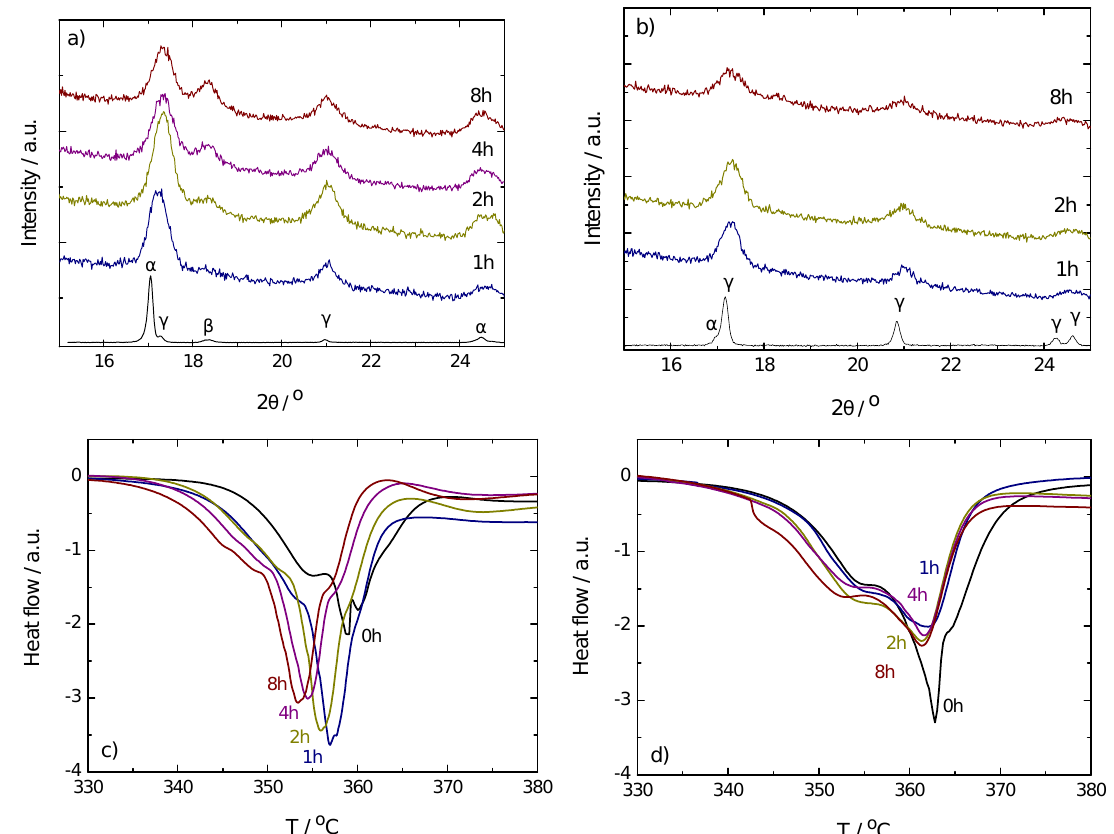
Figure 1. Top: Powder X-ray diffraction (PXD) results on ball milled α βγ (left-hand side, ( a )) and γ (right-hand side, ( b )). Samples were taken from the vials after 1, 2, 4 and 8 h milling. The pattern of the as-received sample is included for comparison. Missing 4 h curve in the γ case due to low signal-to-noise-ratio. Below: Corresponding differential scanning calorimetry (DSC) curves of ball milled α βγ (left-hand side, ( c )) and γ (right-hand side, ( d )). Only the main decomposition region between 330 and 380 ◦ C is shown. Measurements were done under dynamic conditions in protective Ar flow, with 2 ◦ C/min heating rates. The curves have been shifted in the vertical axis to show the peak